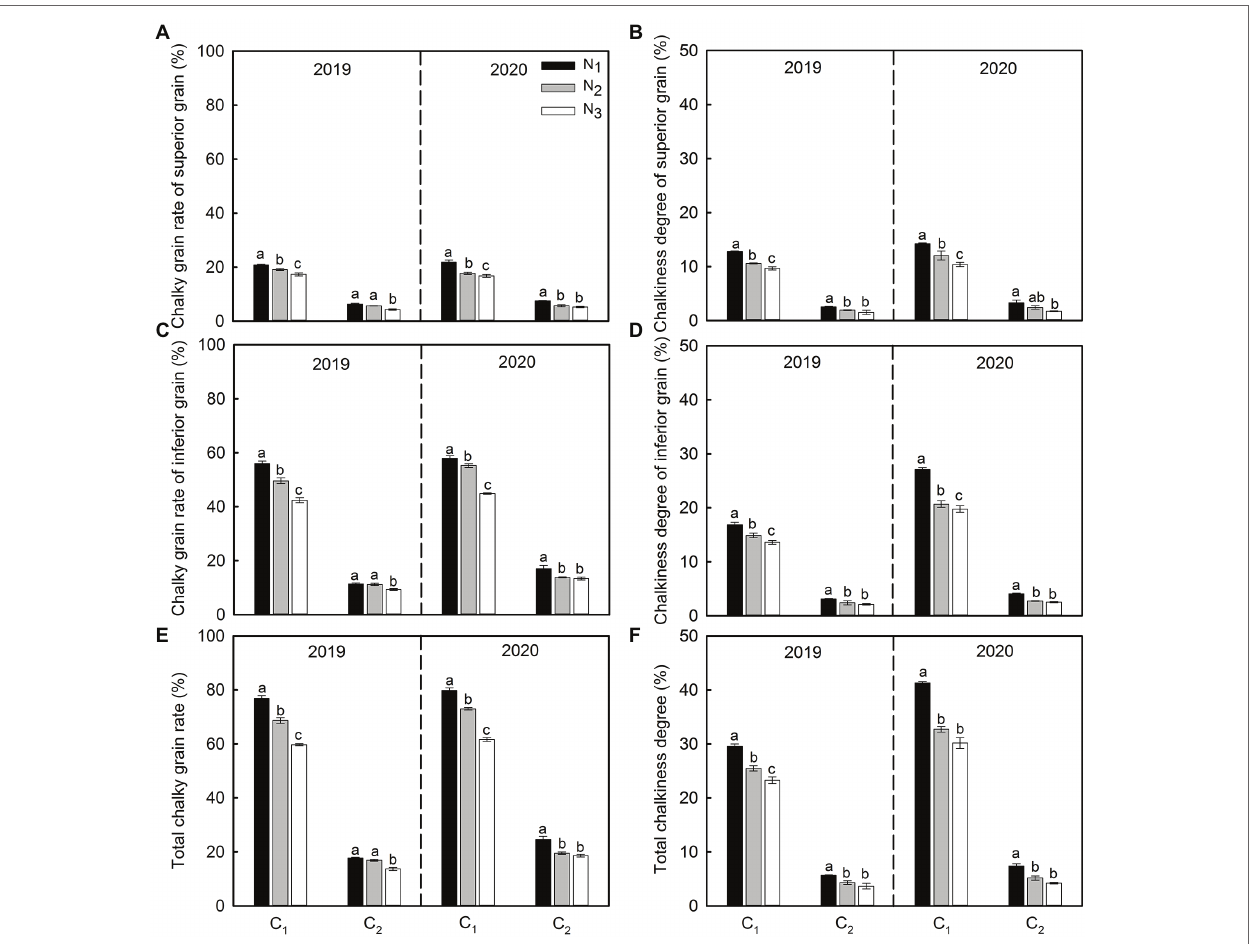
FIGURE 2 | Changes of chalky grain rate (A,C) and chalkiness degree (B,D) of superior and inferior grains and changes of total chalky grain rate (E) and chalkiness degree (F) under different N application rates. Vertical bars represent ±SE of the mean ( n = 3). Different lowercase letters indicate the statistical difference between treatments at the 0.05 level according to the LSD test. C 1 : Chuannongyou 508; C 2 : Shuangyou 573; N 1 : 75 kg ha − 1 ; N 2 : 150 kg ha − 1 ; N 3 : 225 kg ha − 1